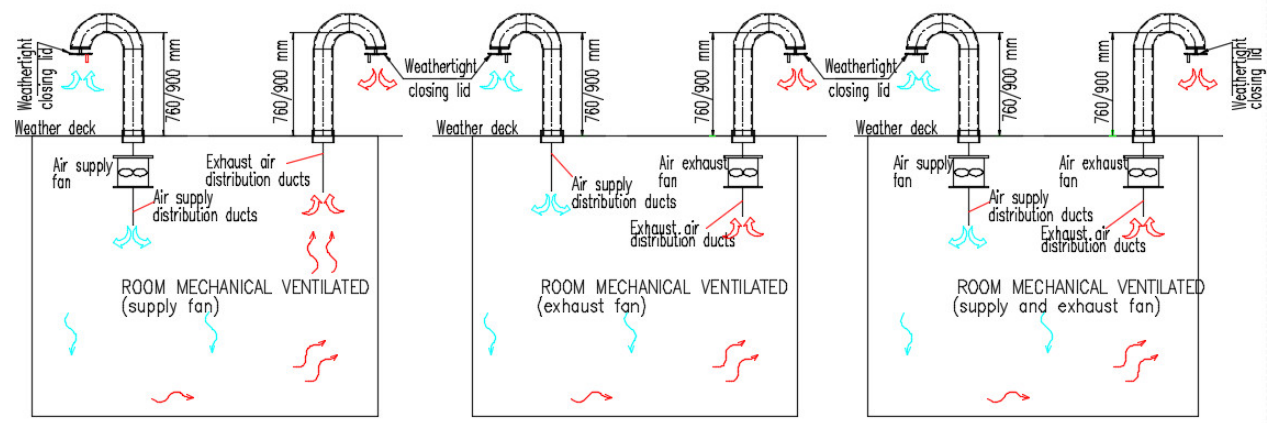
Figure 2. Typical arrangement. Independent mechanical ventilation for a room located below the weather deck.